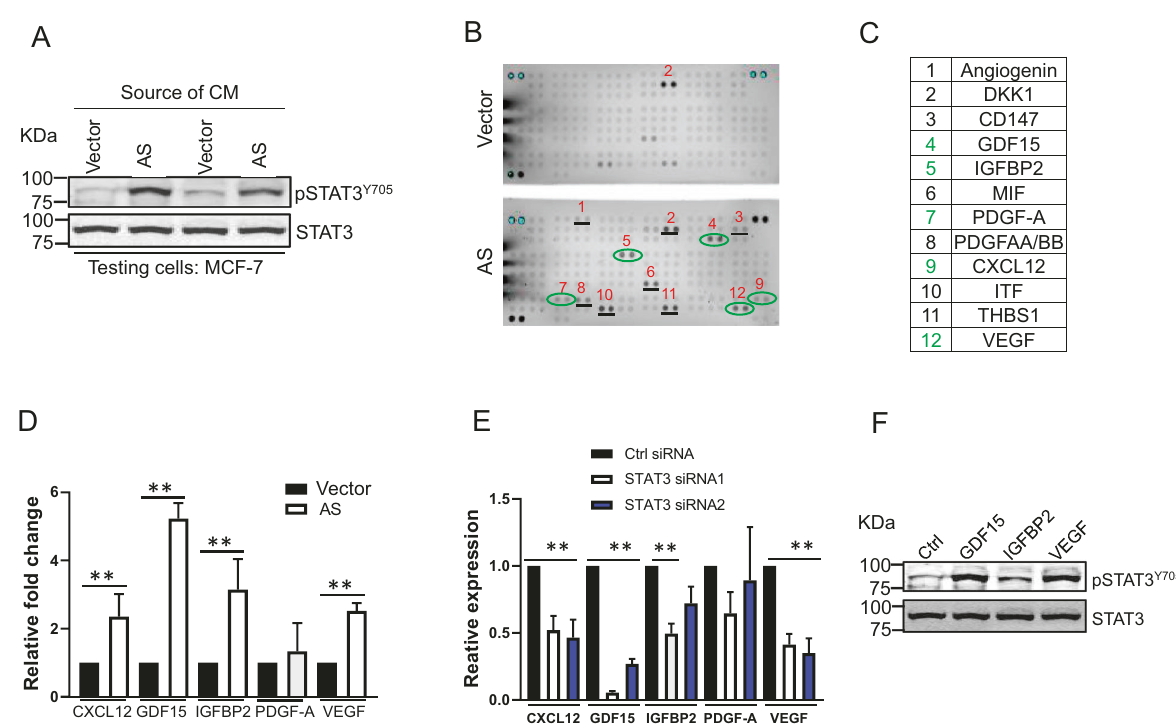
Fig. 5 STAT3-mediated production of cytokines. A Conditioned medium from AS cell culture increases level of pSTAT3 Y705 . The cells were grown in E2 free medium for 3 days before harvesting conditioned medium which was then added to MCF-7 culture. The cells were further cultured for 24 h before western blot. B Detection of different cytokines secreted in vector control cell and AS cell culture. The cells were cultured in E2 free medium for 2 days before the conditioned medium was harvested for cytokine array analysis. C Upregulation of 12 cytokines in AS cells with over a 2-fold as compared to vector control cells. D Upregulation of 5 cytokines at the mRNA level in AS cells as compared to vector control, as detected by qRT-PCR. The cells were prepared as in ( A ) before harvesting for RNA extraction. E , STAT3 siRNAs downregulate cytokine expression in MCF-7 cells, as detected by qRT-PCR. F Cytokines GDF15, IGFBP2 and VEGF stimulate STAT3 activity. MCF- 7 cells were treated with GDF15, IGFBP2, and VEGF at 1 nM for 1 h before harvesting for western blot. Values are mean ± SD ( n = 3). **, p <